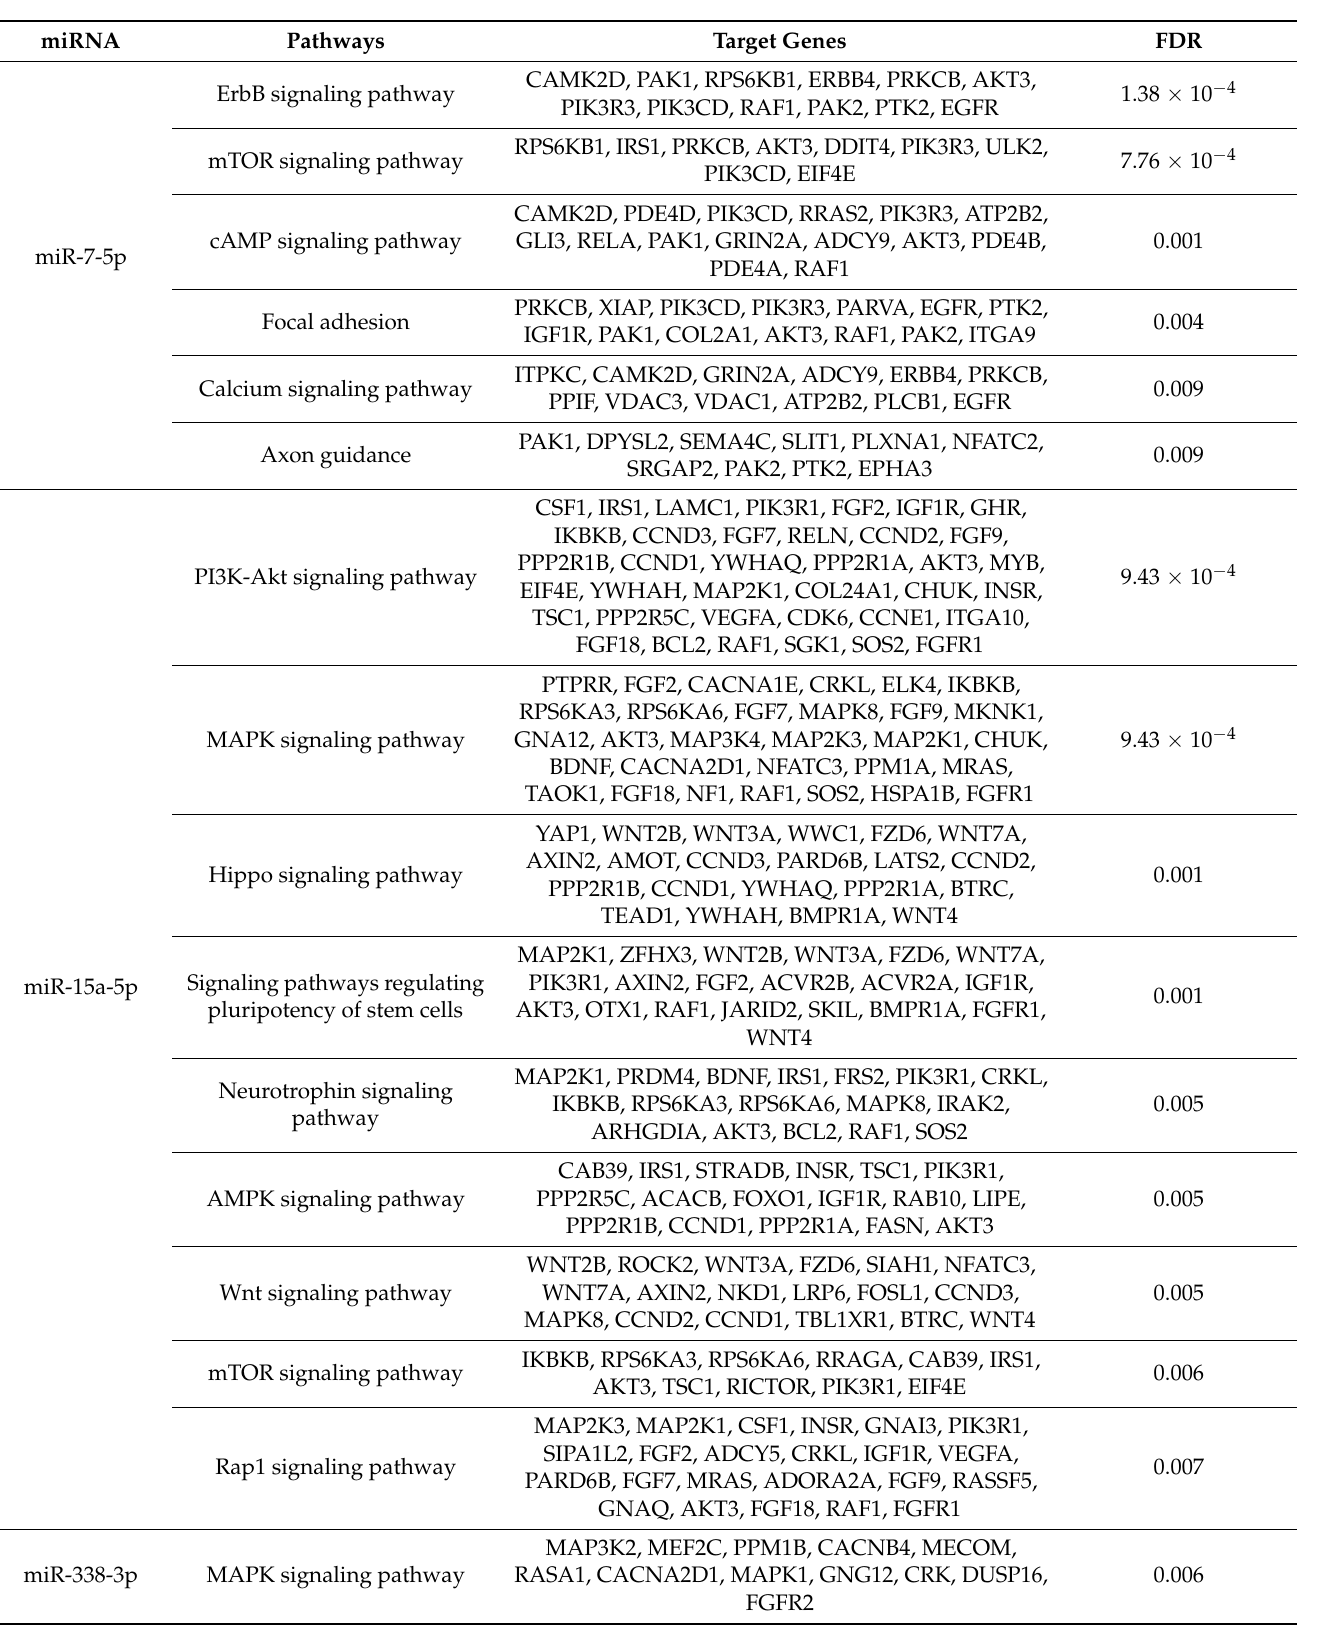
Table 3. KEGG pathway of predicted target genes of the differentially expressed miRNAs. Key pathways have been included in this